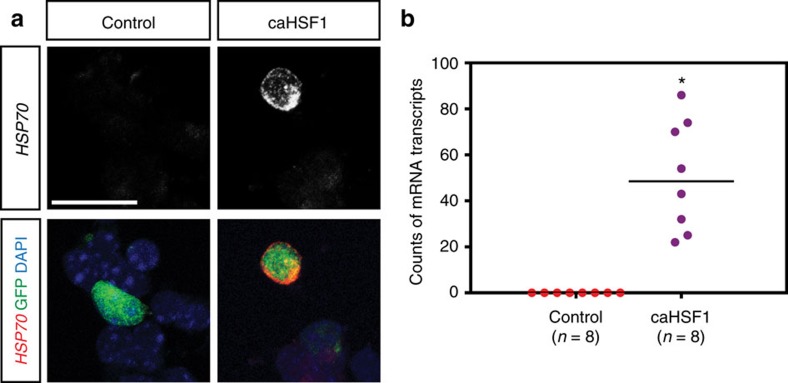
IUE-mediated expression of caHSF1 recapitulates the physiologically relevant levels of HSF1 activation elicited by environmental challenges.(a) Representative images of Hsp70 mRNA expression in pCAGIG (control) or pCAGIG-caHSF1 electroporated cells. The plasmids were introduced into mouse frontal cortices by IUE at E14. The electroporated cells were dissociated 24 h post-electroporation, and plated on culture dishes. 3 h later, Hsp70 mRNAs were detected by smFISH. (b) The graph shows the number of Hsp70 mRNA particles in the control- and caHSF1-electroporated cells. caHSF1 overexpression results in significantly higher numbers of Hsp70 mRNAs compared with the control (*P<0.001 by Mann-Whitney U-Test). Importantly, these numbers fall in the range of the top 5% and 20% of those induced by EtOH and MeHg, respectively (Fig. 1 and Supplementary Fig. 1). Scale bar, 0.02 mm.